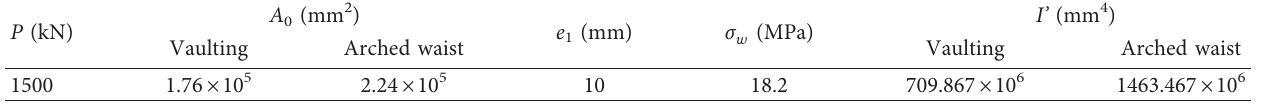
Table 6: Safety verification parameters